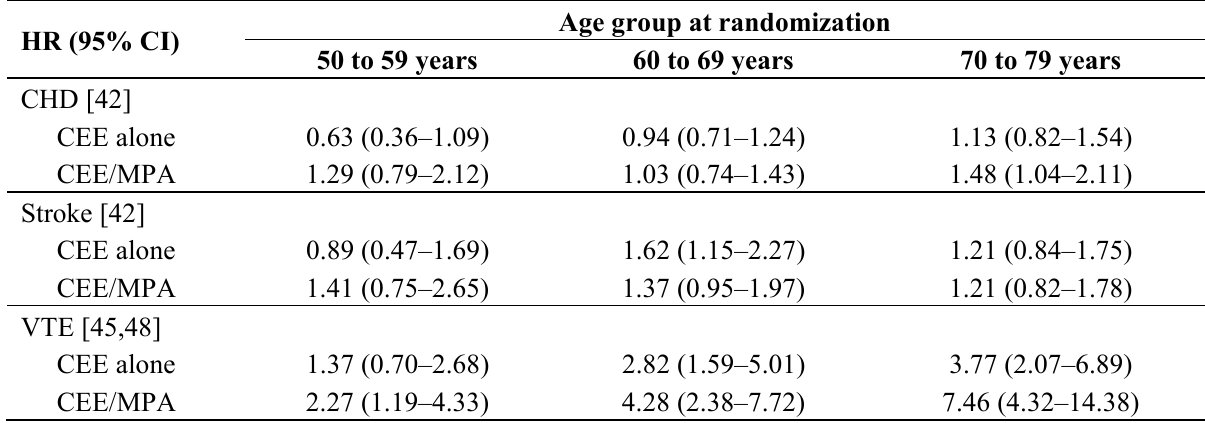
Table 1. Summary of key cardiovascular outcomes with hormone therapy analyzed by age